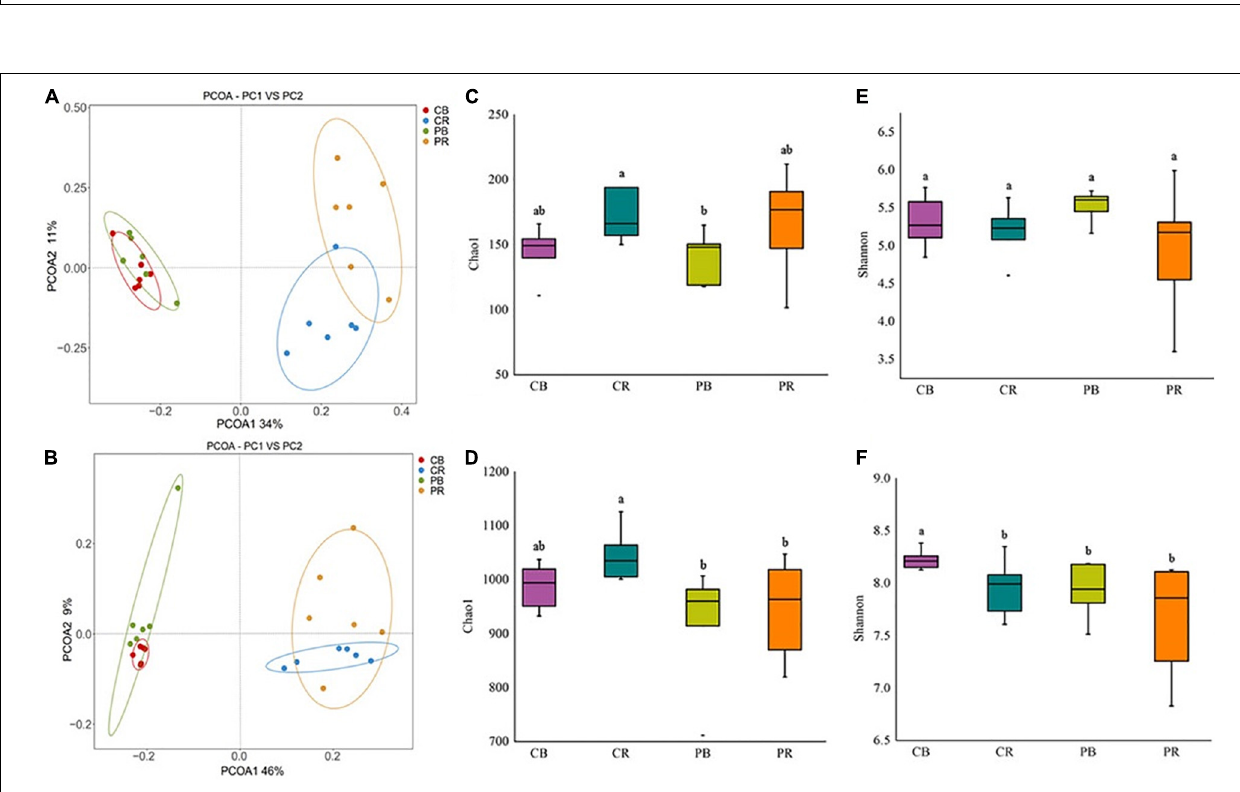
Frontiers in Microbiology |